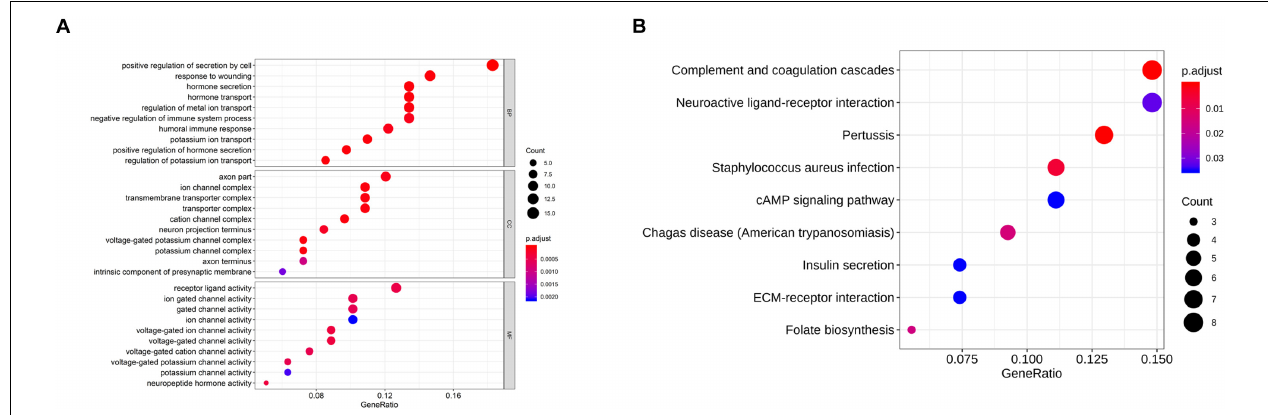
FIGURE 2 | GO and KEGG analyses on the NP-associated genes. (A) The most enriched GO terms of the 94 NP-associated genes; (B) the most activated KEGG pathways of the 94 NP-associated genes.